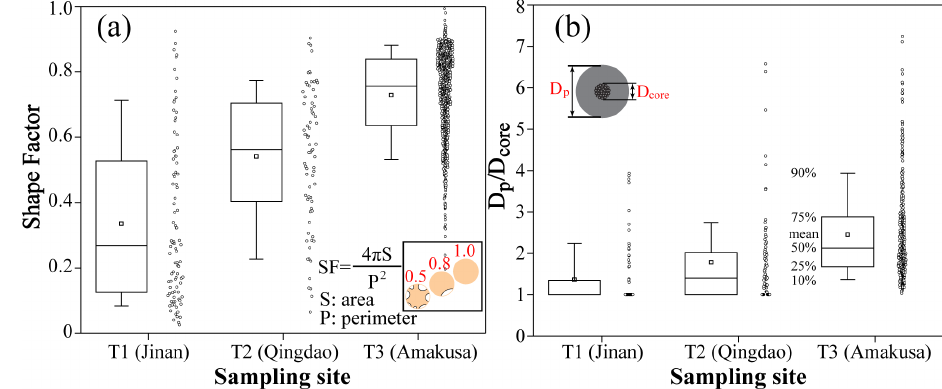
Figure 6. (a) Shape factor of soot-bearing particles and (b) the particle-to-soot core diameter ratio ( D p /D core ) at the three sampling sites.